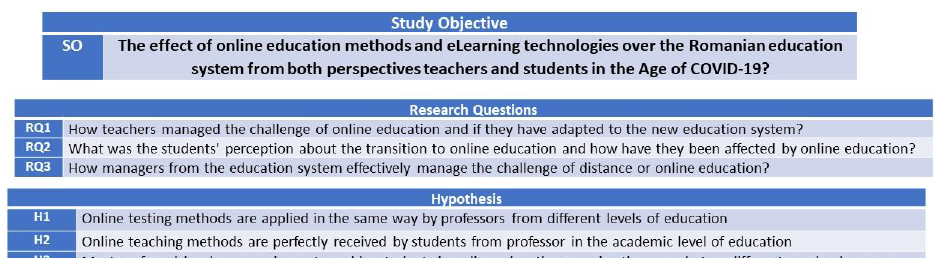
Figure 1. Conceptual research model.